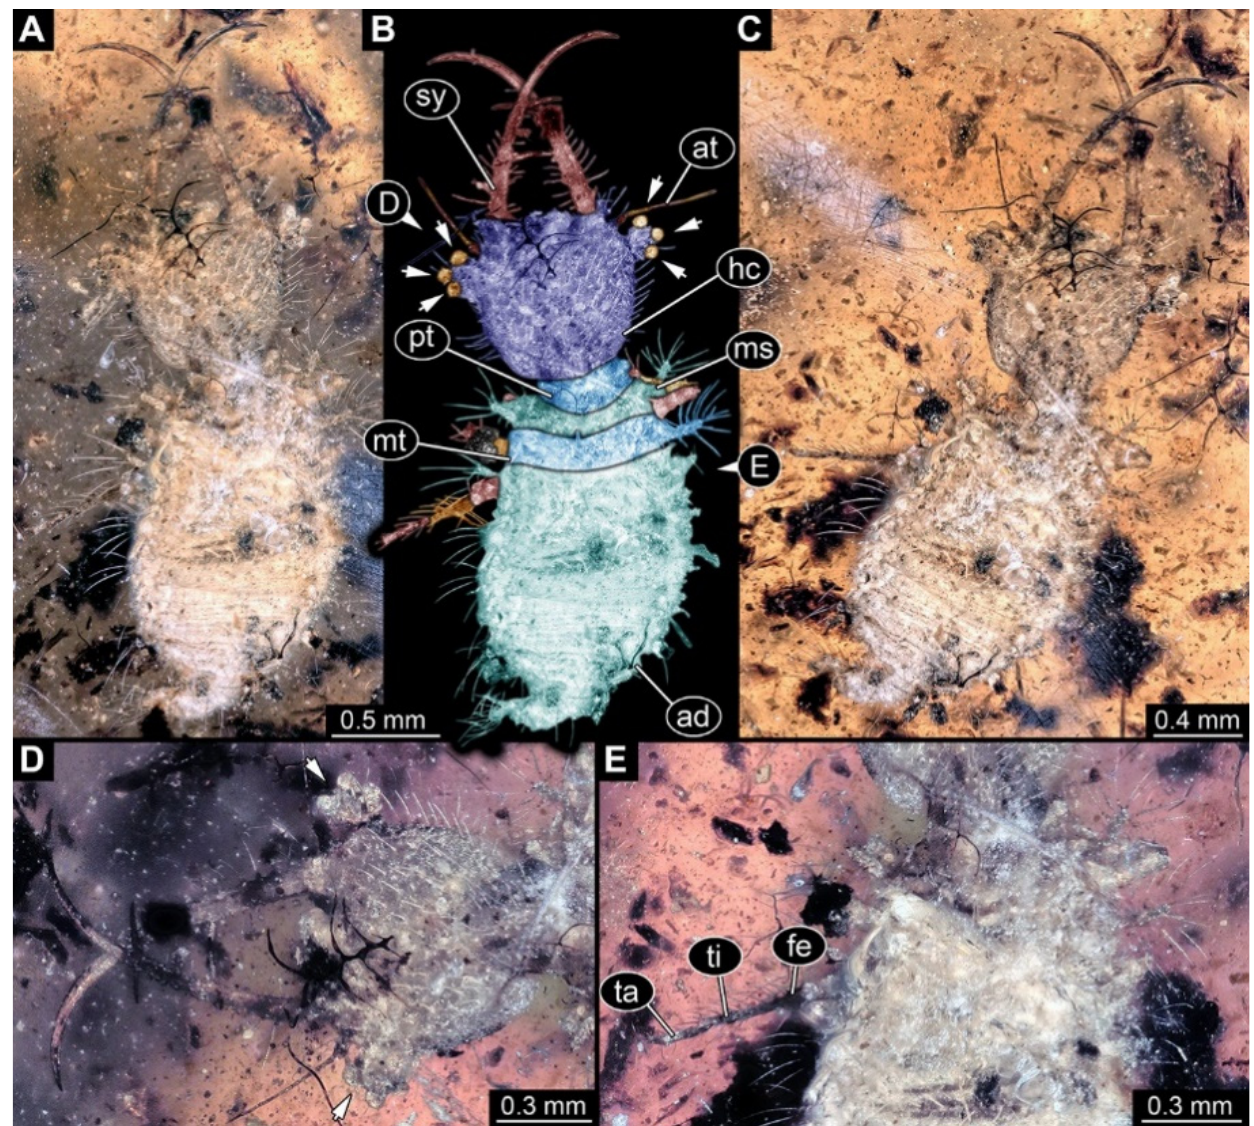
Figure 7. Fossil owllion larva, specimen 3218 (BUB 3378), Cretaceous Kachin amber, Myanmar. ( A ) Overview, dorsal, black background. ( B ) Color-marked version of ( A ). ( C ) Overview, dorsal, white background. ( D ) Close-up on head capsule with fields of stemmata (arrows). ( E ) Close-up on locomotory appendage. Abbreviations: ad = abdomen; at = antenna; fe = femur; hc = head capsule; ms = mesothorax; mt = metathorax; pt = prothorax; sy = stylet; ta = tarsus; ti = tibia. 8.